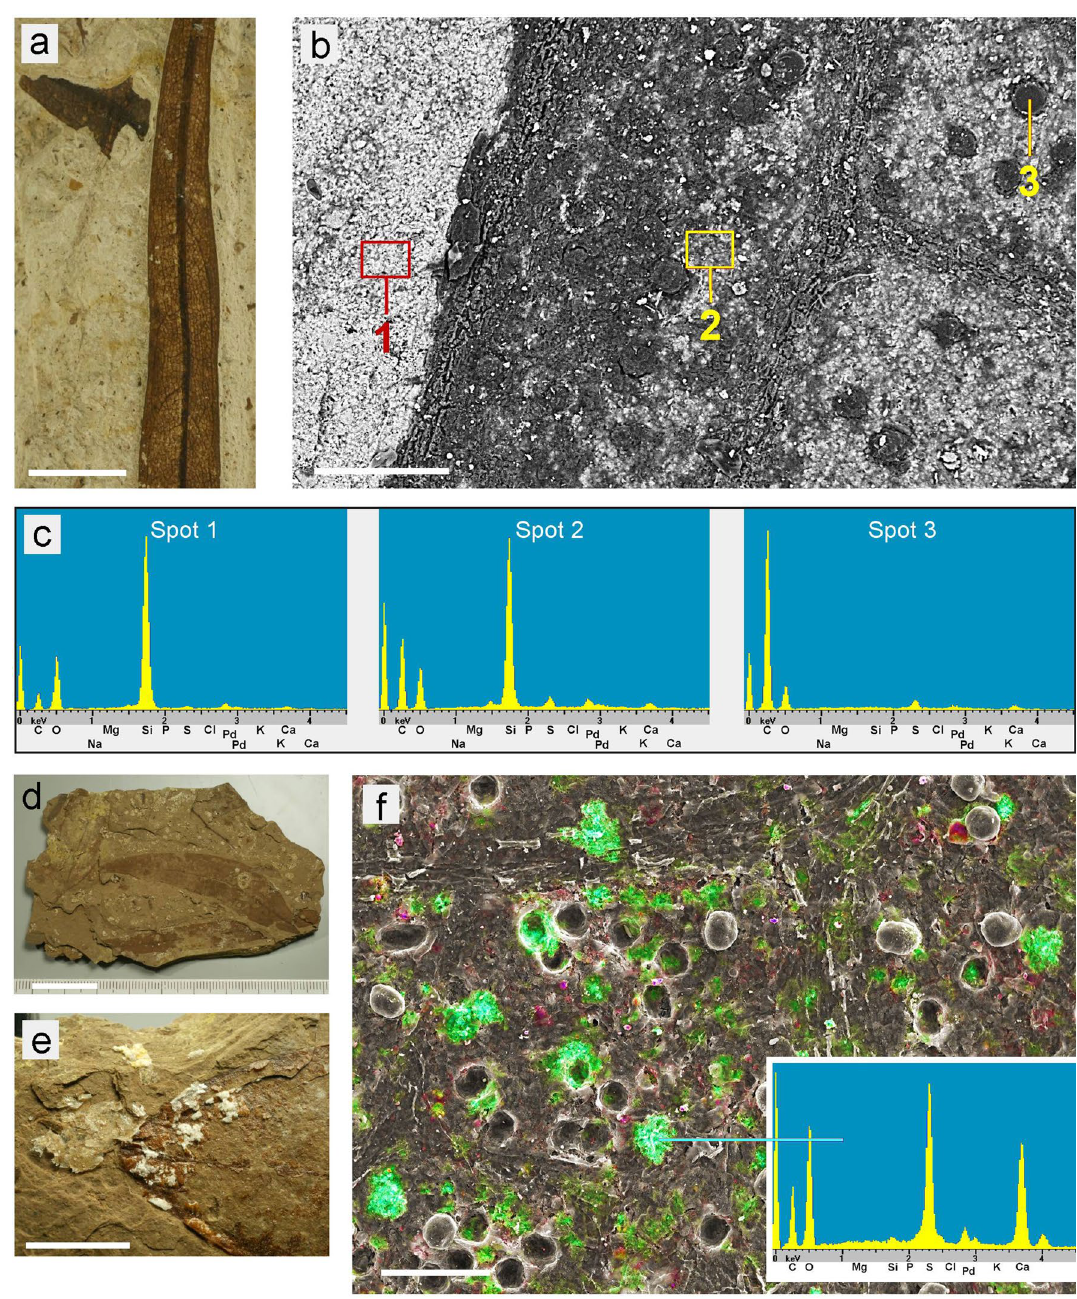
Figure 4. Analyses of samples with globules. ( a – c ) ‘Ro-2.2’ (‘ Sideroxylon salicites’ ). ( a ) Overview photo of the brown leaf embedded in white mineral. ( b ) Compositional contrast (BSE) SEM image showing organic leaf material dark, background mineral (left part) bright, and ghost mineral inclusions in the leaf area (bright). The fractured globules (e.g., Spot 3) appear dark, indicating organic material. ( c ) EDX spectra show the composition of background sediment (Spot 1; mainly Si and O), the leaf area ‘Spot 2’ (Si, C, O, and traces of S and Al), and globules (Spot 3; mainly C with little O and S). ( d – f ) ‘Ro-110.6’ (‘Magnoliopsida’). ( d , e ) Overview photos showing the leaf embedded in coal. ( f ) Combined SEM topographic contrast and element-mapping image showing Ca in green and Si in red; organic structures are in grey scales. The EDX spectrum in the box shows the co-localization of Ca, S, and O as calcium sulphate (CaSO 4 ). Globules are organic (C and little O). Many cavities contain a shell of CaSO 4 which had surrounded the globules which have been torn out of the coal matrix. Calcium sulphate occurred also on other parts of the sample in form of gypsum deposits ( e ). Scale bars: ( a , e ) = 5 mm; ( b , f ) = 100 µm; ( d ) = 20